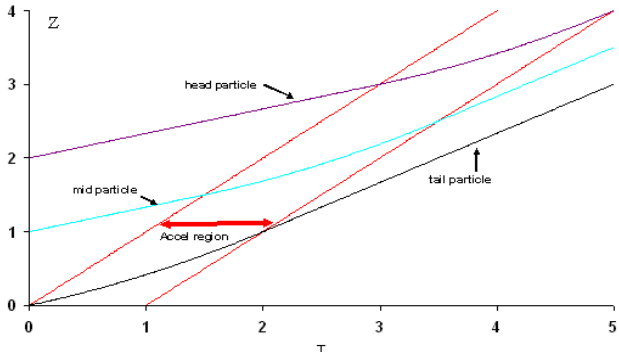
FIG. 18. (Color) Trajectories in an ion bunch that initially ex- tends over two circuit ramp lengths and moves with an initial velocity 1 = 3 the circuit speed. The bunch is then accelerated in a (cid:3) 3 = 4 ‘‘snow plow mode’’ with u 0